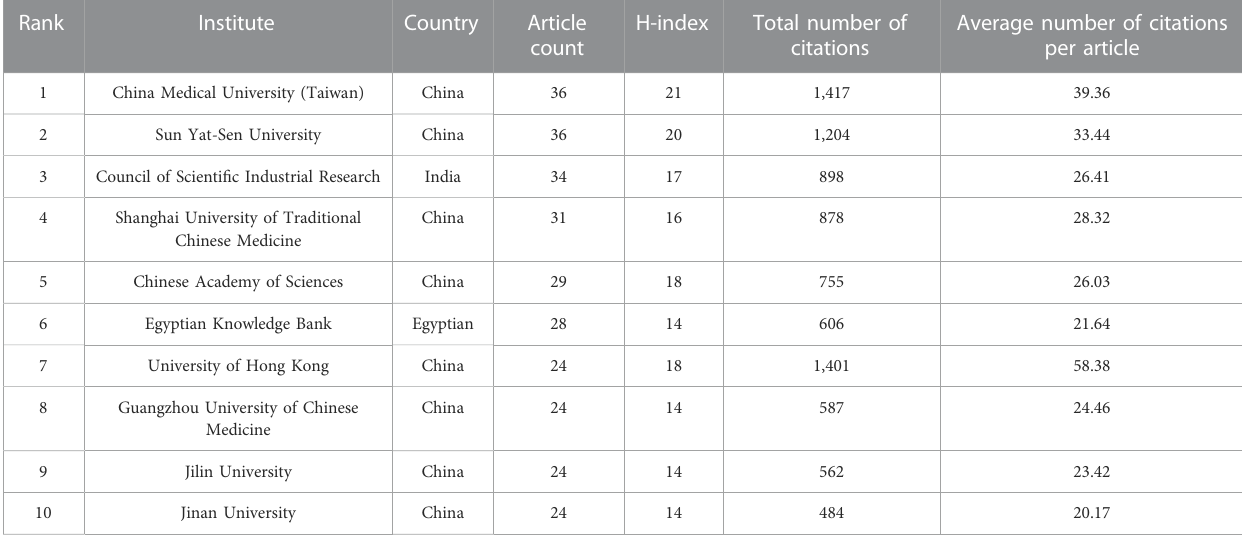
TABLE 2 Top 10 institutes that contributed publications on BBR and